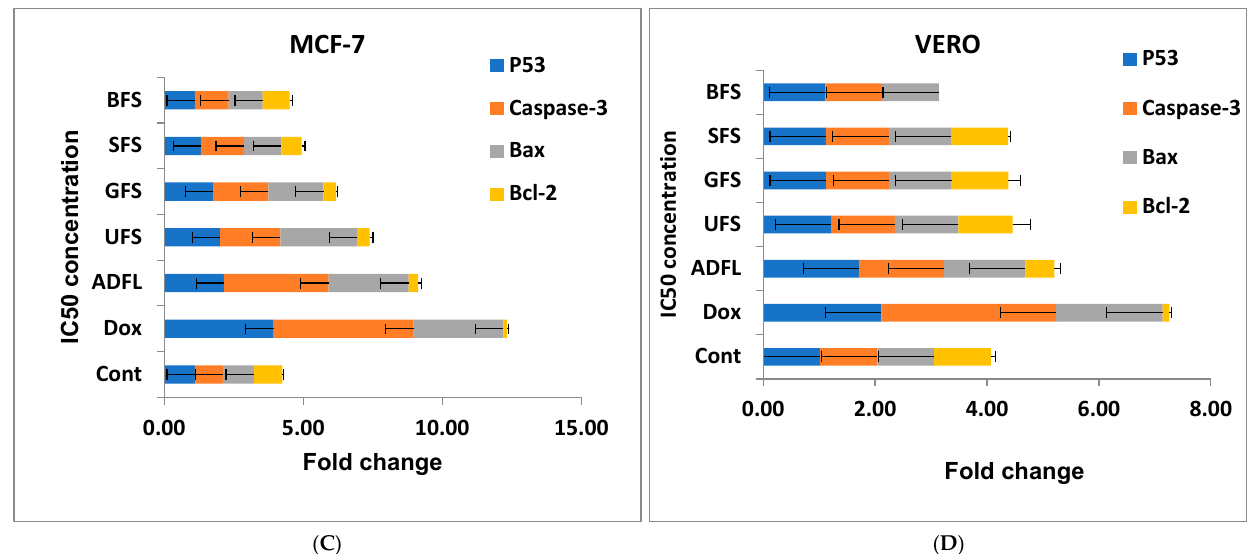
Figure 2. ( A ) Fold change in the level of mRNA expression of various apoptosis genes via RT-PCR in human hepatic carcinoma cell lines (HepG2) exposed to IC 50 (µg mL − 1 ) doses of doxorubicin (Dox) as standard drug, air-dried fenugreek leaves (ADFL), untreated fenugreek seeds (UFS), germinated fenugreek seeds (GFS), soaked fenugreek seeds (SFS), and boiled fenugreek seeds (BFS) for 24 h. ( B ) Fold change in the level of mRNA expression of various apoptosis genes via RT-PCR in human colon carcinoma cell lines (HCT-116) exposed to IC 50 (µg mL − 1 ) doses of doxorubicin (Dox) as stand- ard drug, ADFL, UFS, GFS, SFS, and BFS for 24 h. ( C ) Fold change in the level of mRNA expression of various apoptosis genes via RT-PCR in human breast carcinoma cell lines (MCF-7) exposed to IC 50 (µg mL − 1 ) doses of doxorubicin (Dox) as standard drug, ADFL, UFS, GFS, SFS, and BFS for 24 h. ( D ) Fold change in the level of mRNA expression of various apoptosis genes via RT-PCR in nor- mal kidney cell lines (VERO) exposed to IC 50 (µg mL − 1 ) doses of doxorubicin (Dox) as standard drug, ADFL, UFS, GFS, SFS, and BFS for 24 h. The data provided are mean ± standard deviation from three separate experiments. p < 0.05 versus control.